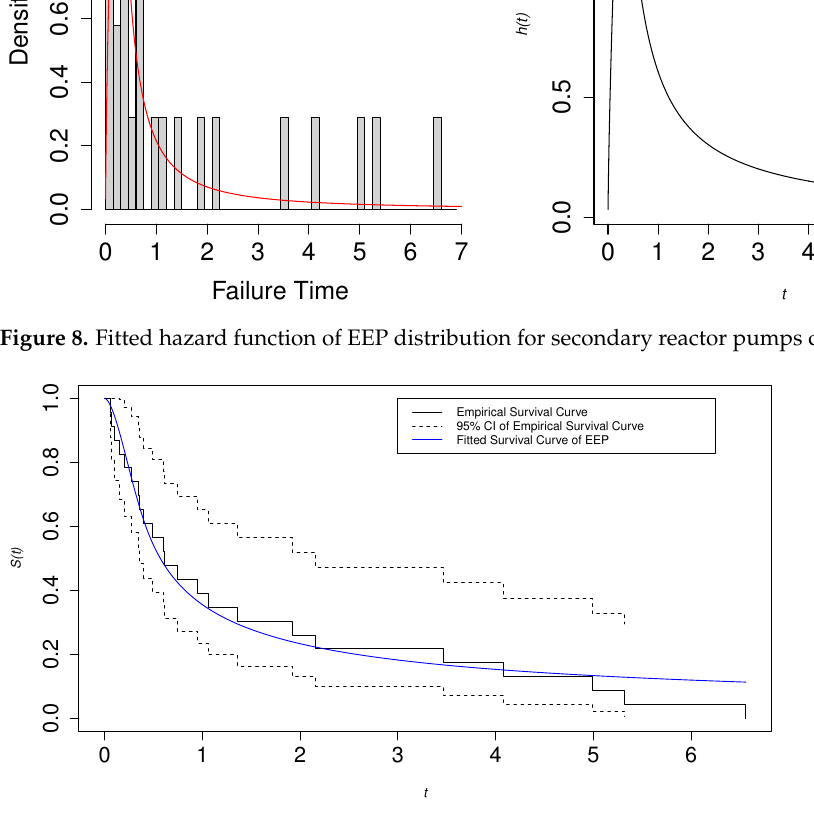
Figure 9. Fitted EEP survival curve for secondary reactor pumps data set.